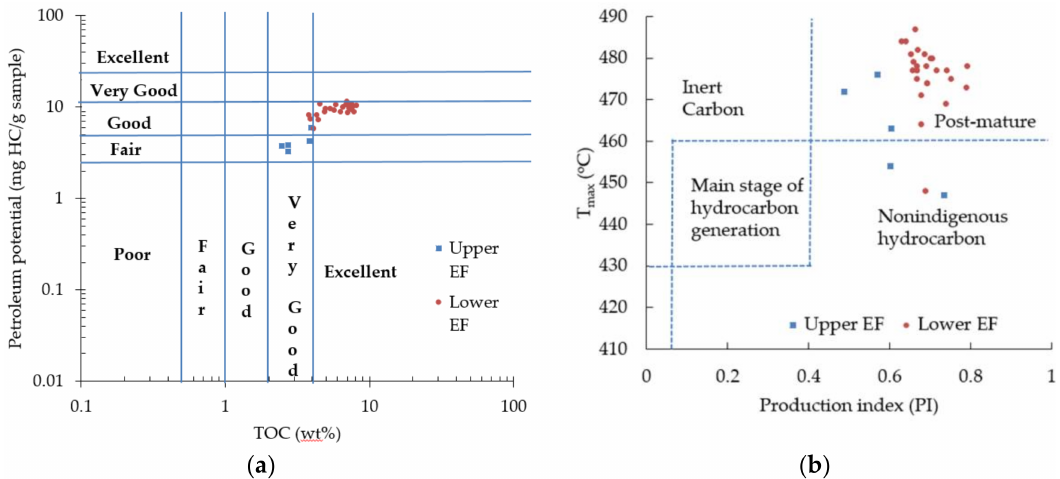
Figure 2. Source rock potential and maturation of the Eagle Ford (EF) Shale. ( a ) Plot of total organic carbon (TOC) versus petroleum potential; ( b ) plot of production index versus T